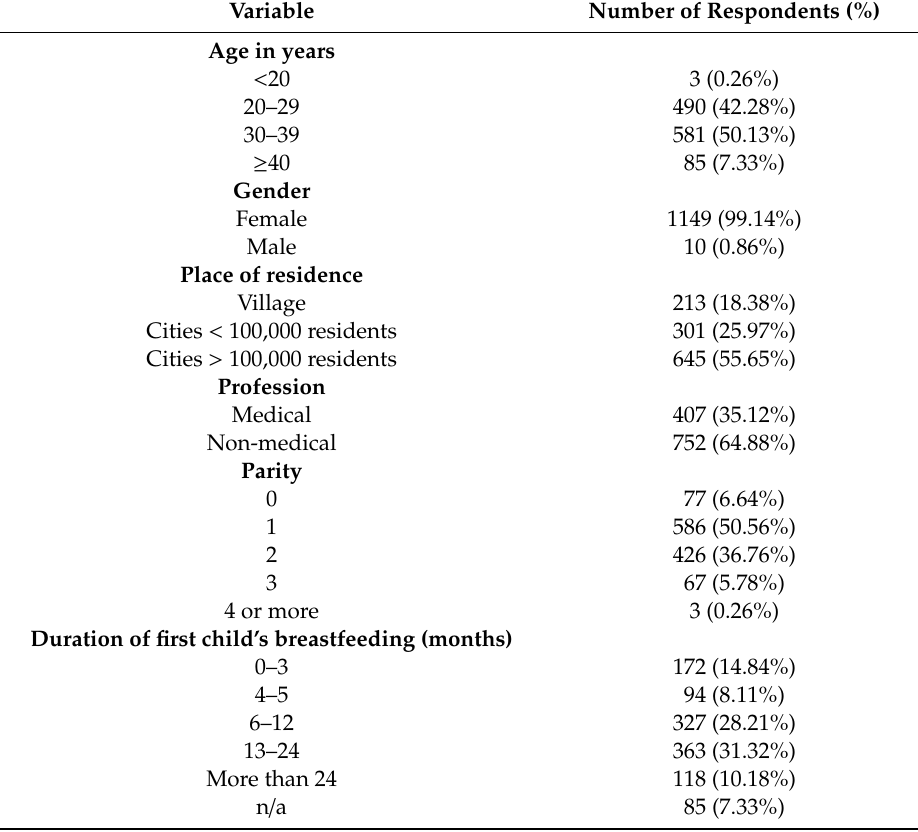
Table 1. Characteristics of respondents ( n =